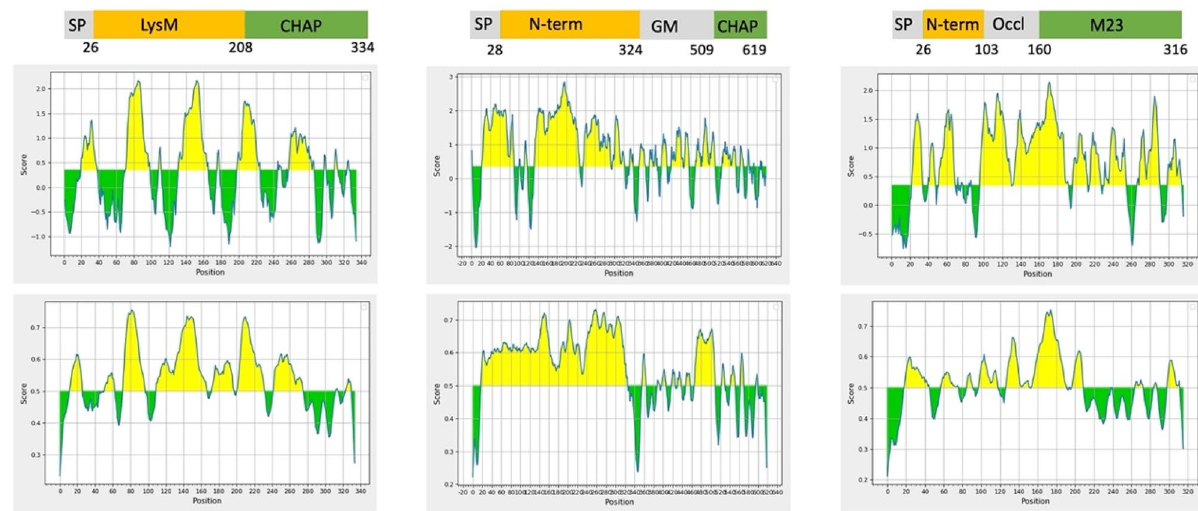
Figure 10. Prediction of immunogenic linear and conformational epitopes in Sle1, Aly and LytM. Linear and conformational epitopes in Sle1, Aly and LytM were predicted using the Bepipred 1.0 and 2.0 tools using the default threshold of